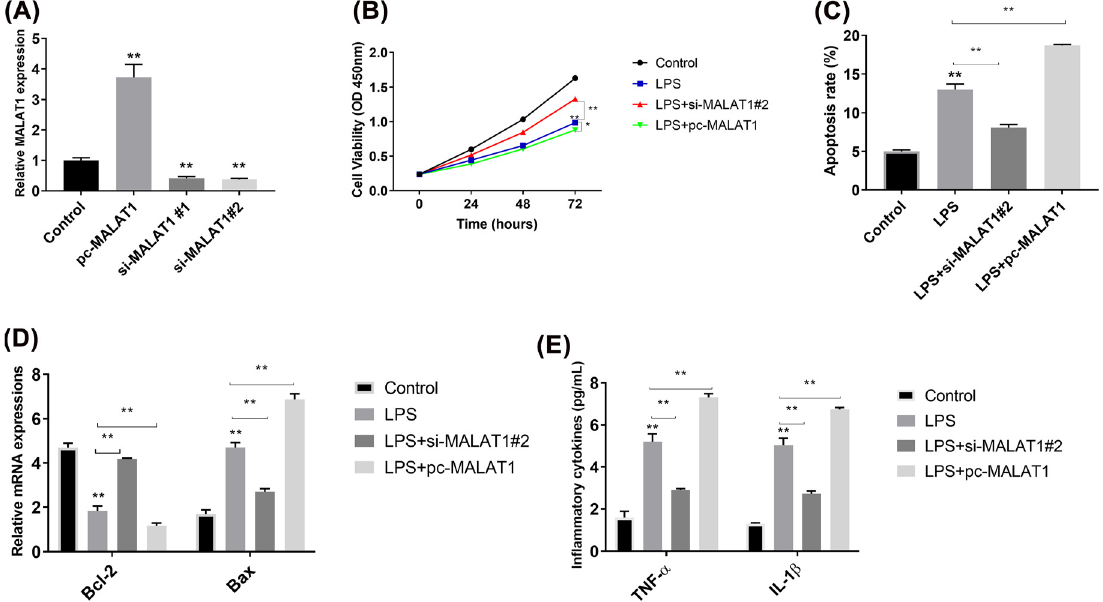
Figure 2: Impacts of metastasis-associated lung adenocarcinoma transcript 1 (MALAT1) on modulating progressions of periodontal ligament cells (PDLCs) with lipopolysaccharide (LPS)